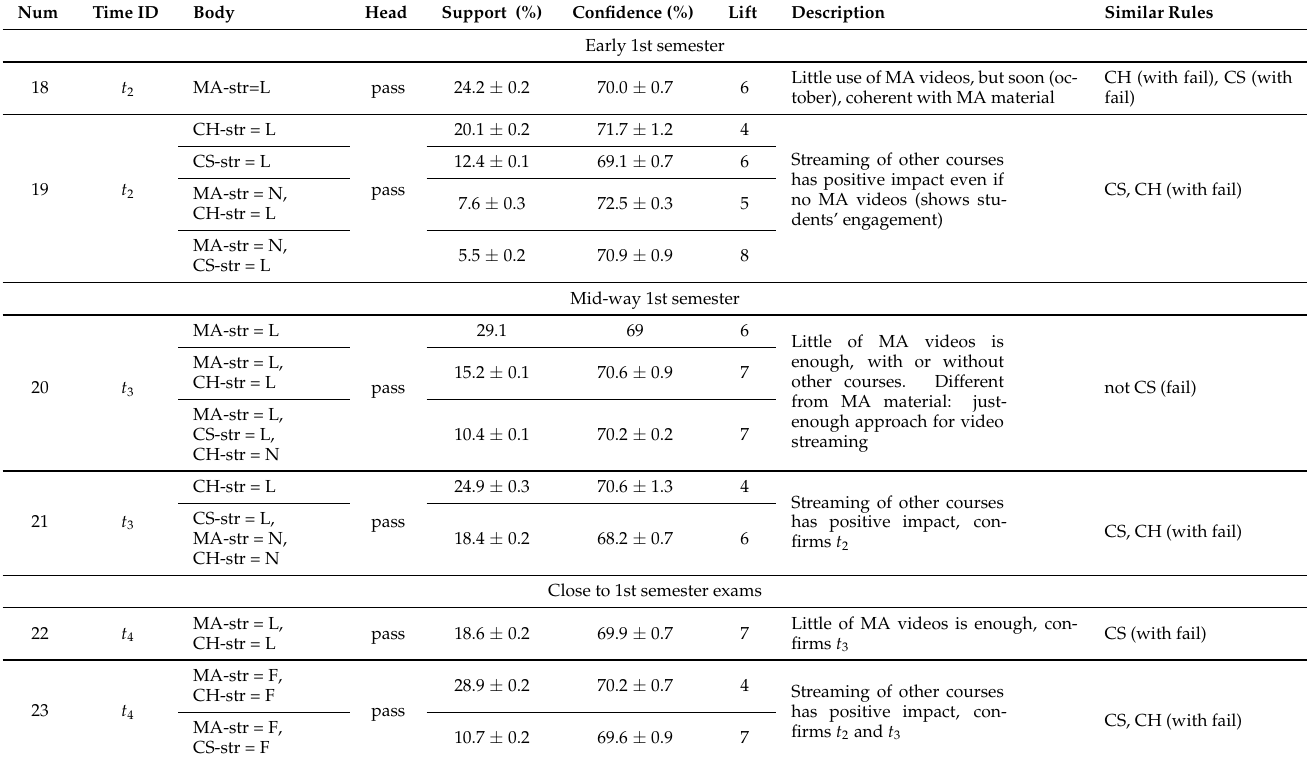
Table 8. High-quality rules mined from the MA datasets including only STREAM-VL features. minsup = 1%, minconf = 50%, mincorr = 2. Support and confidence values of each of the selected rules are averaged over the 5 cross-validation folds (average and standard deviation are specified).